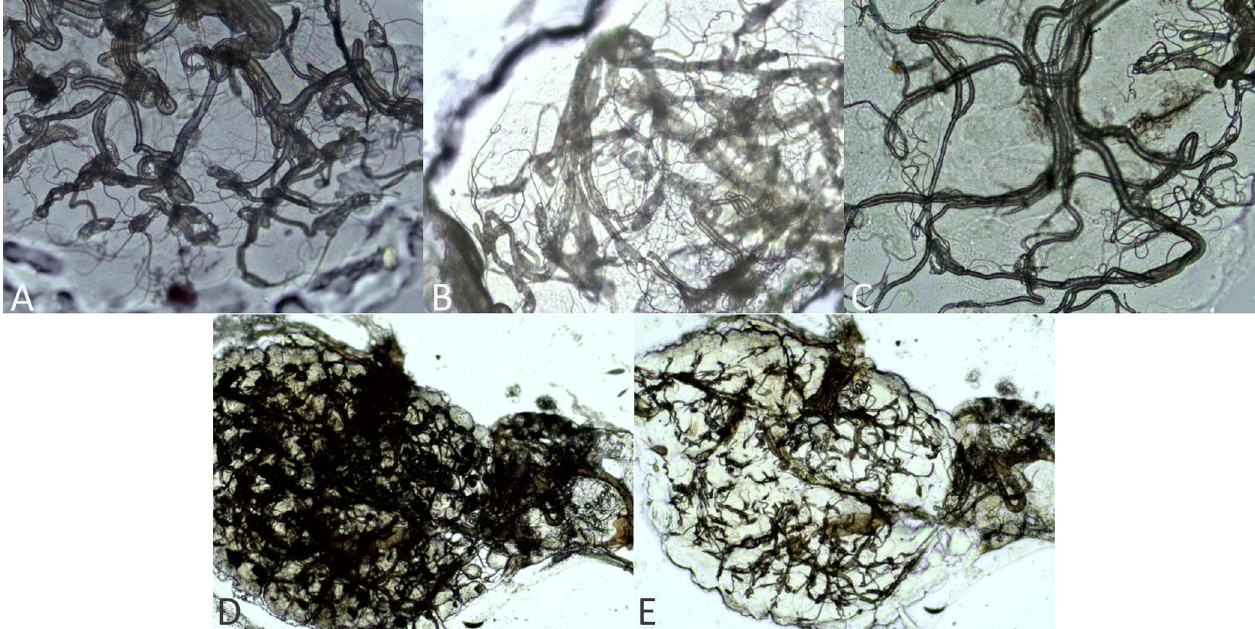
Fig 2. Categories used for ovarian grading in Cx . tarsalis . Parity status graded as A) nulliparous with all tightly wound skeins, B) intermediate with a combination of tight and loose skeins, or C) parous with all unwound skeins. D) Dark mass observed in some ovaries, likely due to egg protein, which is E) removed with washing with deionized water. Ovarian mounts presented at 400x magnification (A-C) or 100x magnification (D-E).